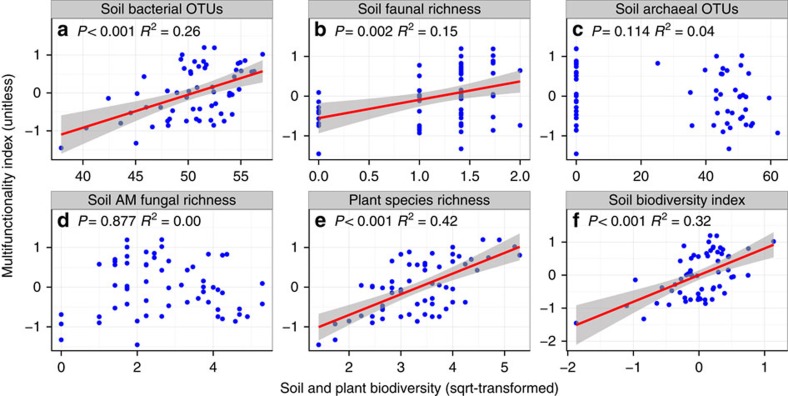
Relationships between below- and aboveground biodiversity and ecosystem multifunctionality.Relationships between soil bacterial (a) soil faunal (b) soil archaeal (c) soil AM fungal (d) plant (e) and soil (f) biodiversity and ecosystem multifunctionality (EMF). There were no significant linear relationships between EMF and soil archaeal biodiversity or soil AM fungal biodiversity. The red fitted lines are from OLS regression. Only significant fitted lines are displayed on the graphs. Shaded areas show 95% confidence interval of the fit.